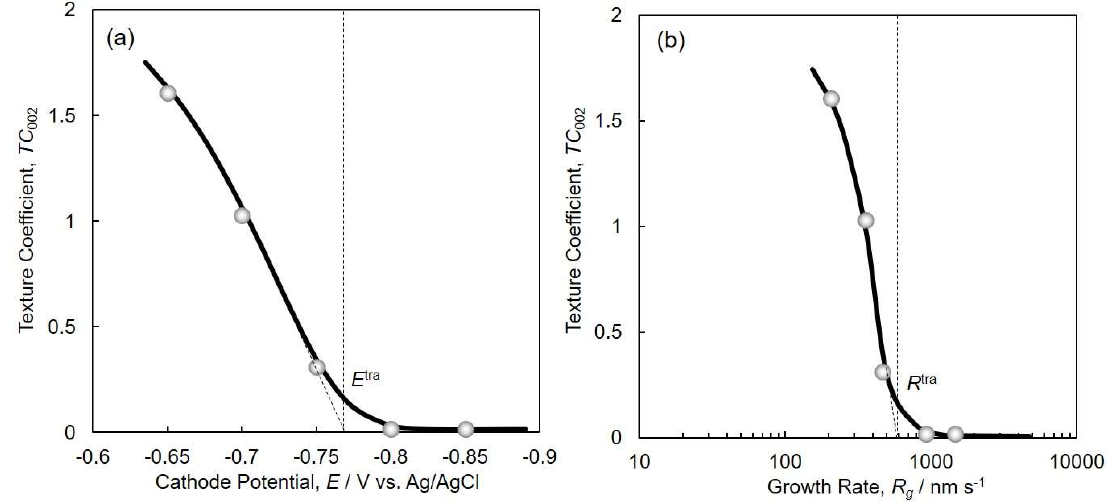
Figure 8. Effect of cathode potential ( a ) and growth rate ( b ) on texture coefficient TC 002 of electrodeposited Co nanocrystal arrays. electrodeposited Co nanocrystal